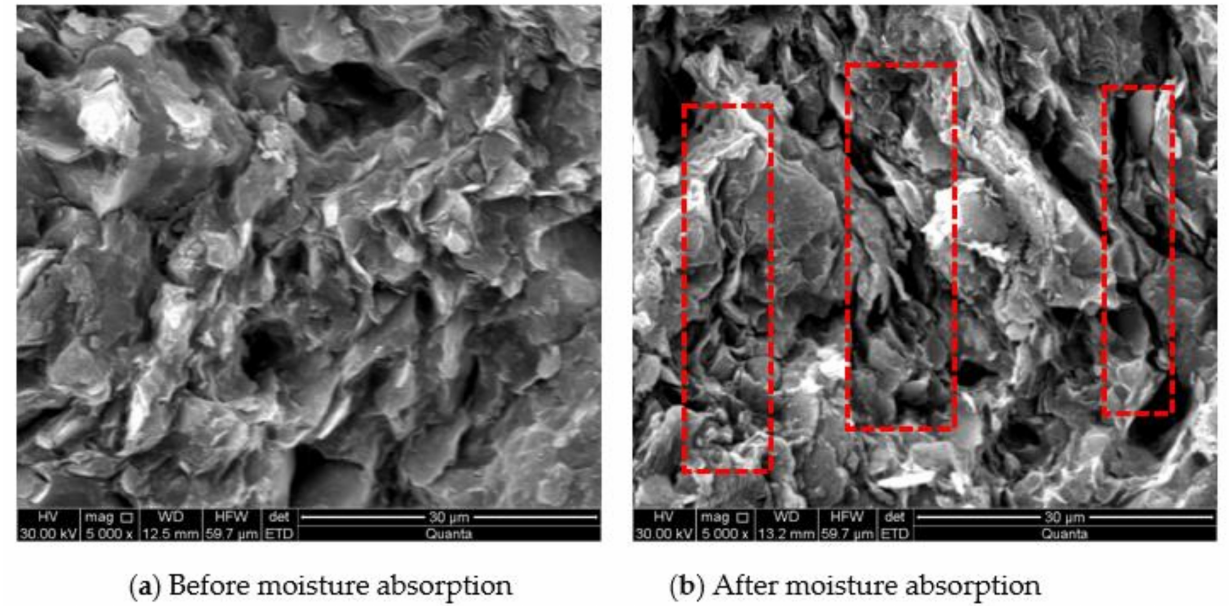
Figure 12. Results of SEM before and after gaseous water sorption.